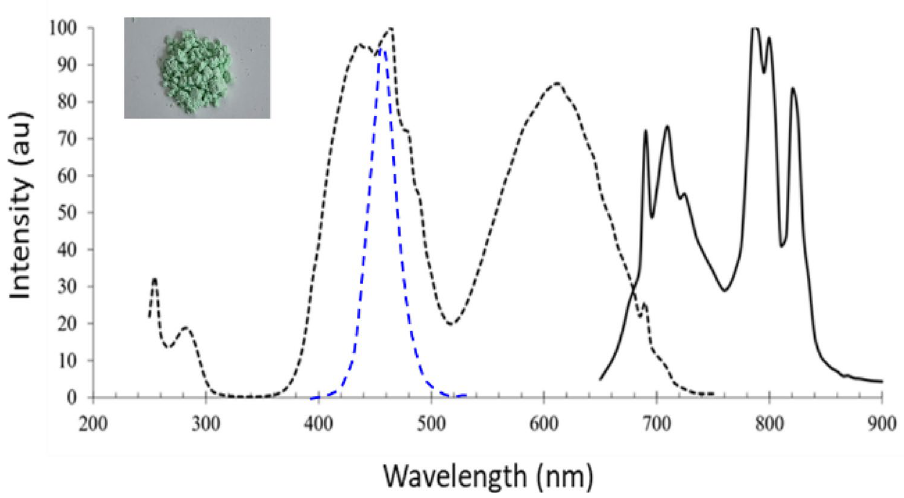
Figure 12. The excitation and emission spectra of the IR phosphor. The blue dash line is the measured spectrum of a blue die.